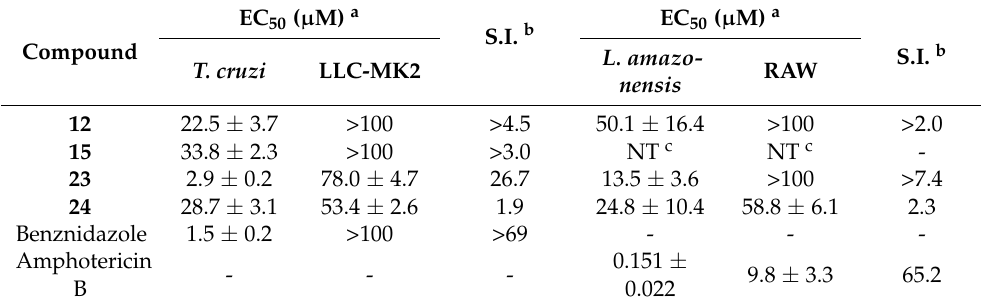
Table 4. Evaluation of compounds 12 , 15 , 23 , and 24 against intracellular amastigotes of T. cruzi and L. amazonensis and LLC-MK2 and RAW host